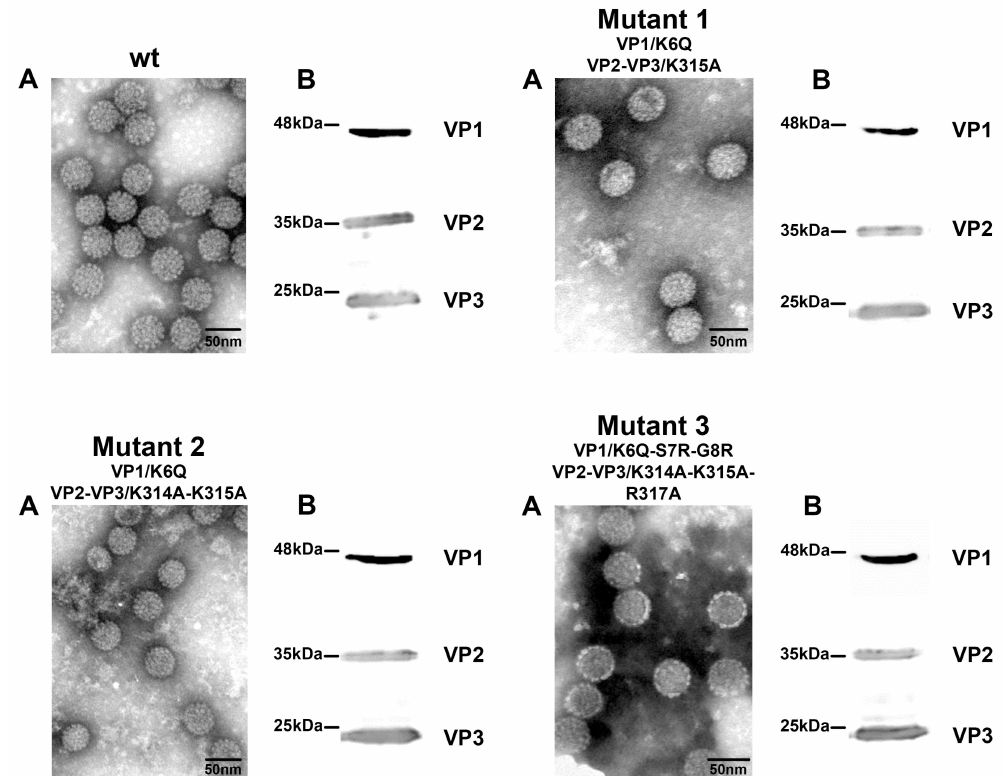
Figure 4. Characterization of the mutated viruses. The wt virus or mutant viruses 1, 2, and 3, isolated from transfected cells were contrasted by phosphotungstic acid and visualized by electron microscopy (Bars = 100 nm) ( A ); Presence of the capsid proteins was detected by Western blot using specific antibody against VP1 and VP2/3 ( B